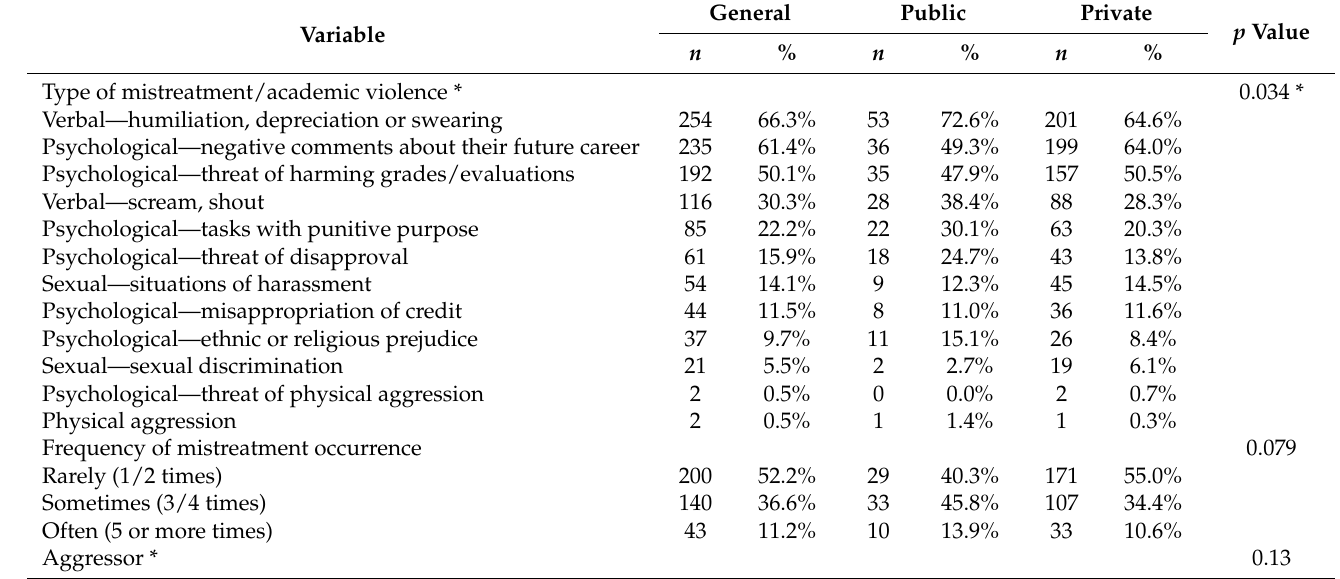
Table 2. Frequency distribution of the characteristics of the mistreatment suffered by the research participants, by